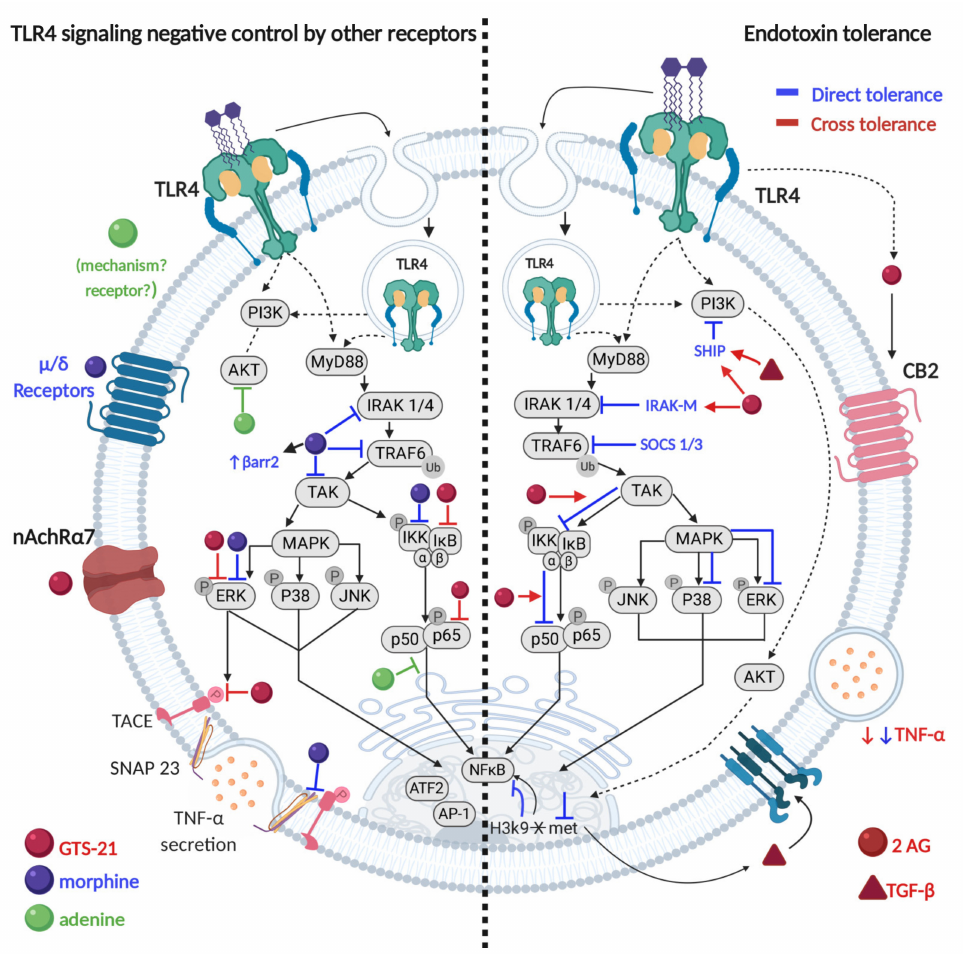
Figure 3. Control of TLR4-mediated signaling in MCs. Morphine, GTS-21 and adenine have been proven to control TLR4-induced cytokine production on MCs (left side). Morphine exert its e ff ects by acting at µ / δ opioid receptors while GTS-21 (see reference [54]) inhibits LPS-dependent response through the activation of nAchR α 7 receptor. Although adenine has been demonstrated to inhibit TLR4-induced responses, the receptor or mechanism by which it mediates that e ff ect has not been described. Symbols of the distinct molecules were included in the interior of the cell to illustrate the points of TLR4 signaling pathway blockade. ET on MCs (right side) can be developed by direct (blue) or indirect (red) mechanisms. Direct tolerance depends on the increase of SHIP, IRAK-M and SOCS1 / 3 expression and the inhibition of IKK, p65-NF κ B, p38 and ERK1 / 2 phosphorylation. Inhibition of the histone H3K9 demethylation also participates on this phenomenon. Cross tolerance